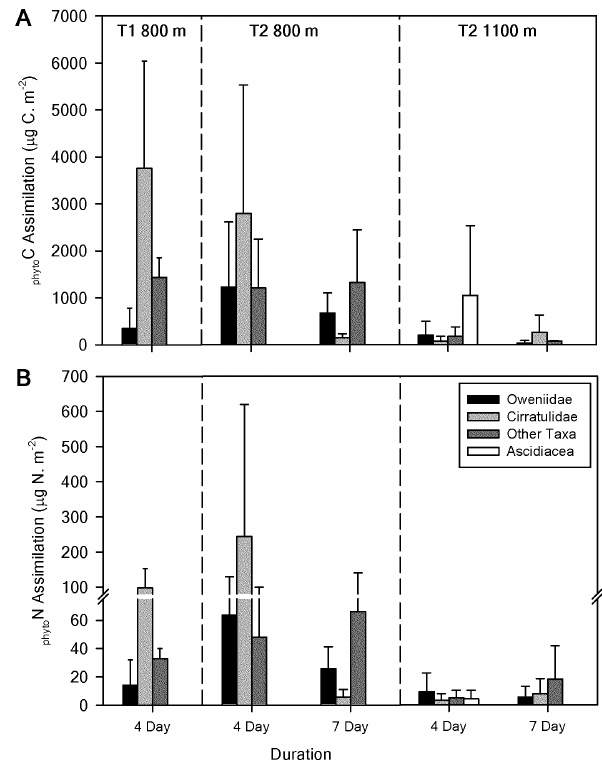
Fig. 5. Mean assimilation ( ± standard deviation) of (A) phyto C and (B) phyto N by the main macrofaunal taxa, over four and seven day incubation